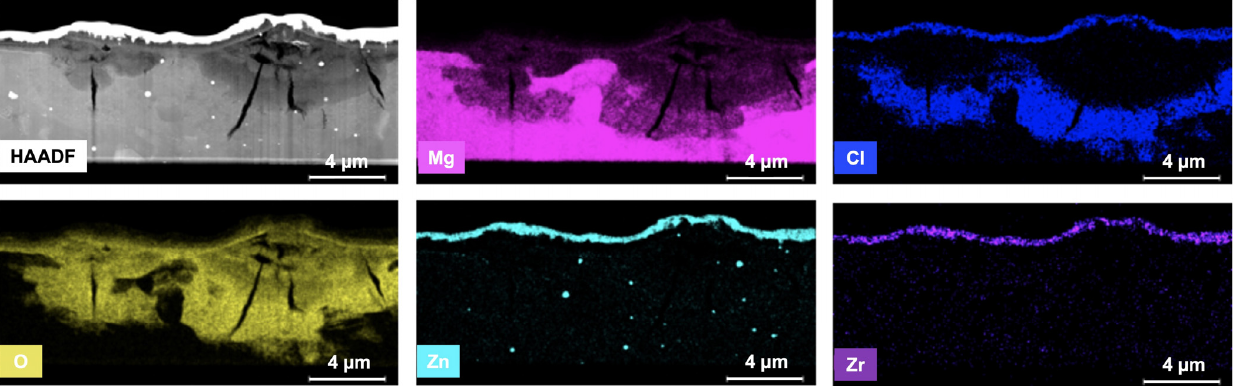
Figure 13. STEM/EDS of the FIB lamella and corresponding X-ray maps displaying the spatial location of Mg, Cl, O, Zn, and Zr in the corrosion product of ZEK100 Mg.